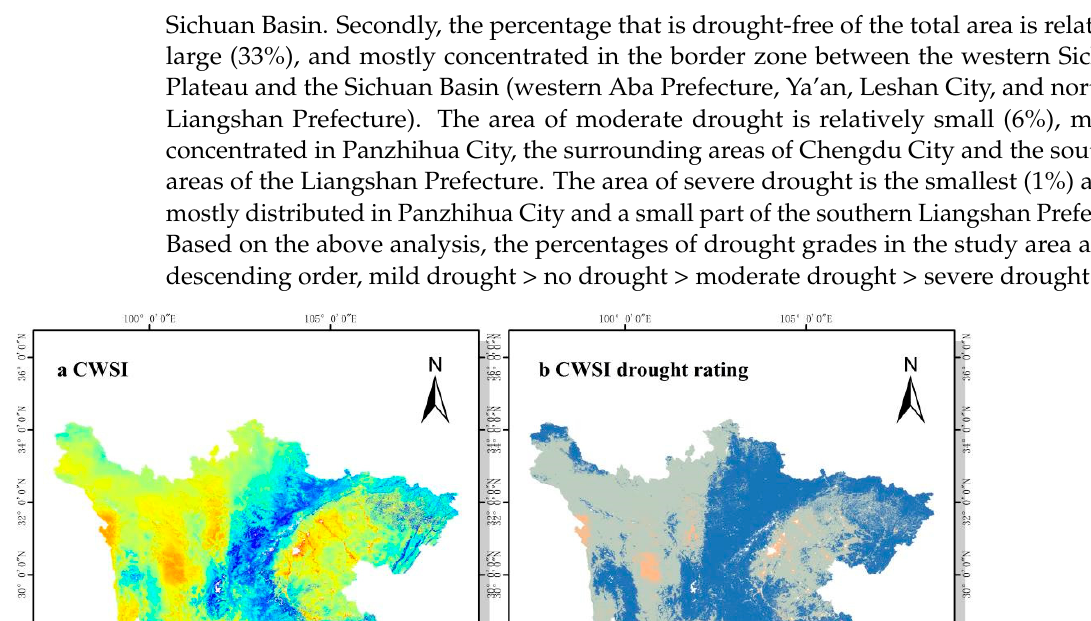
Table 2. Category of significant variation of drought